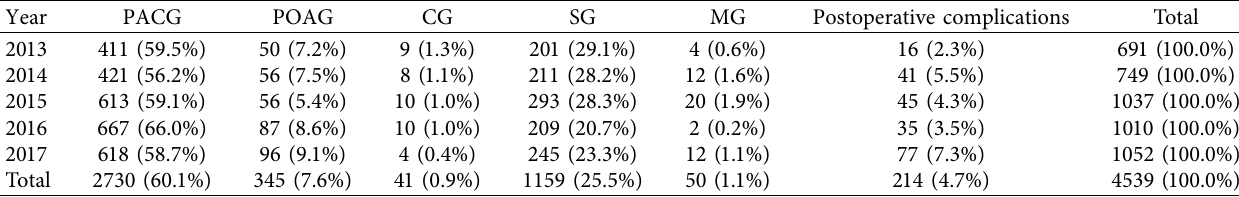
Table 1: Distribution of glaucoma types from 2013 to 2017.